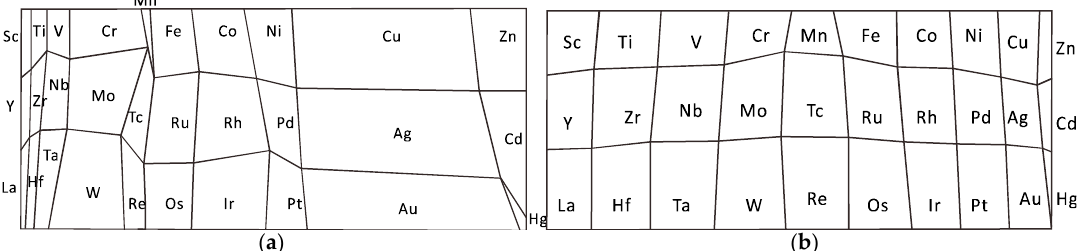
Figure 5. Quadrilateral table cartograms of periodic table of chemical elements: ( a ) Relative thermal conductivity; ( b ) Relative boiling point. Table 3. Data representation precision, deformation and calculation time by the proposed method when μ = 0.15.